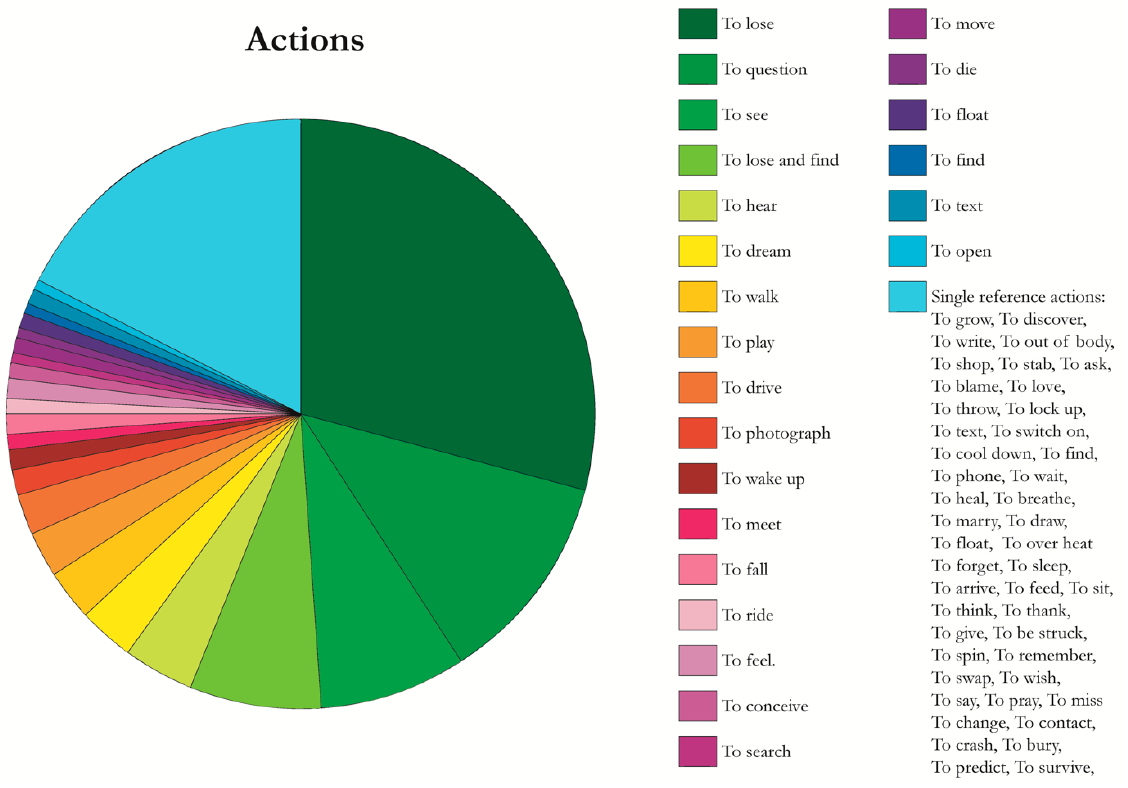
Figure 3. The Preston Market Mystery Project: The Propositional Stalls (analysis of mysteries) (Newling 2008) (Courtesy of the artist).